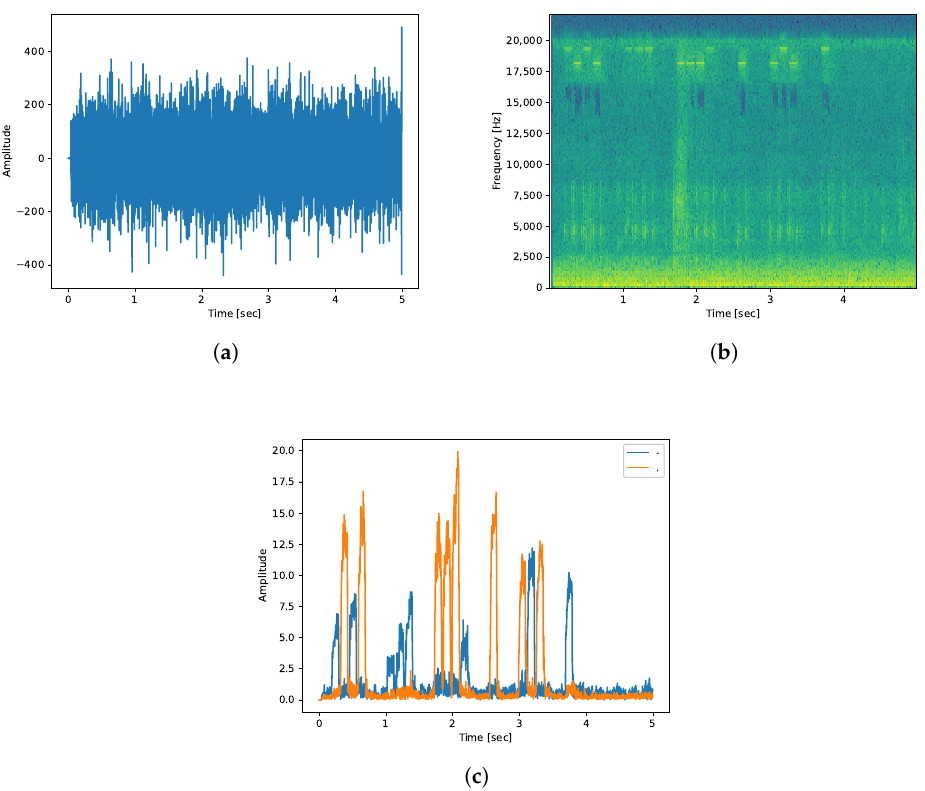
Figure 2. Time waveform, spectrogram, and frequency amplitude signals of sound encoding the word “covert” using beep sound recorded by a smartphone at a distance of 50 cm. These figures allow visual identification of data when transferring simple data. ( a ) Time waveform of sound transferring Morse code “covert” using beep sound. ( b ) Spectrogram of sound transferring Morse code “covert” using beep sound. ( c ) Frequency amplitude signals of sound transferring Morse code “covert” using beep